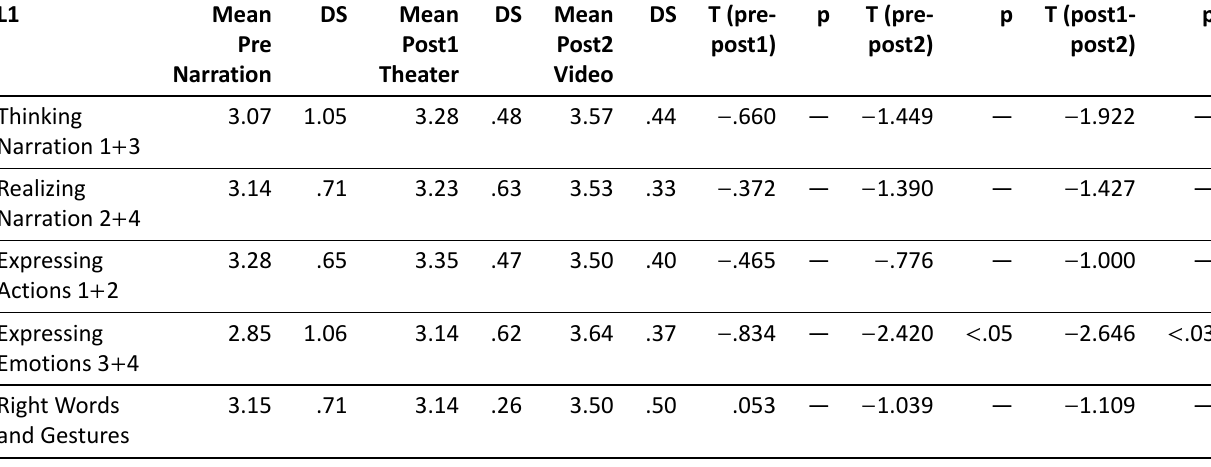
Table 2. Pre-Test, post-test 1 theater and post-test 2 video: means, standard deviations and results of t-test for self-efficacy according to categories for Italian students